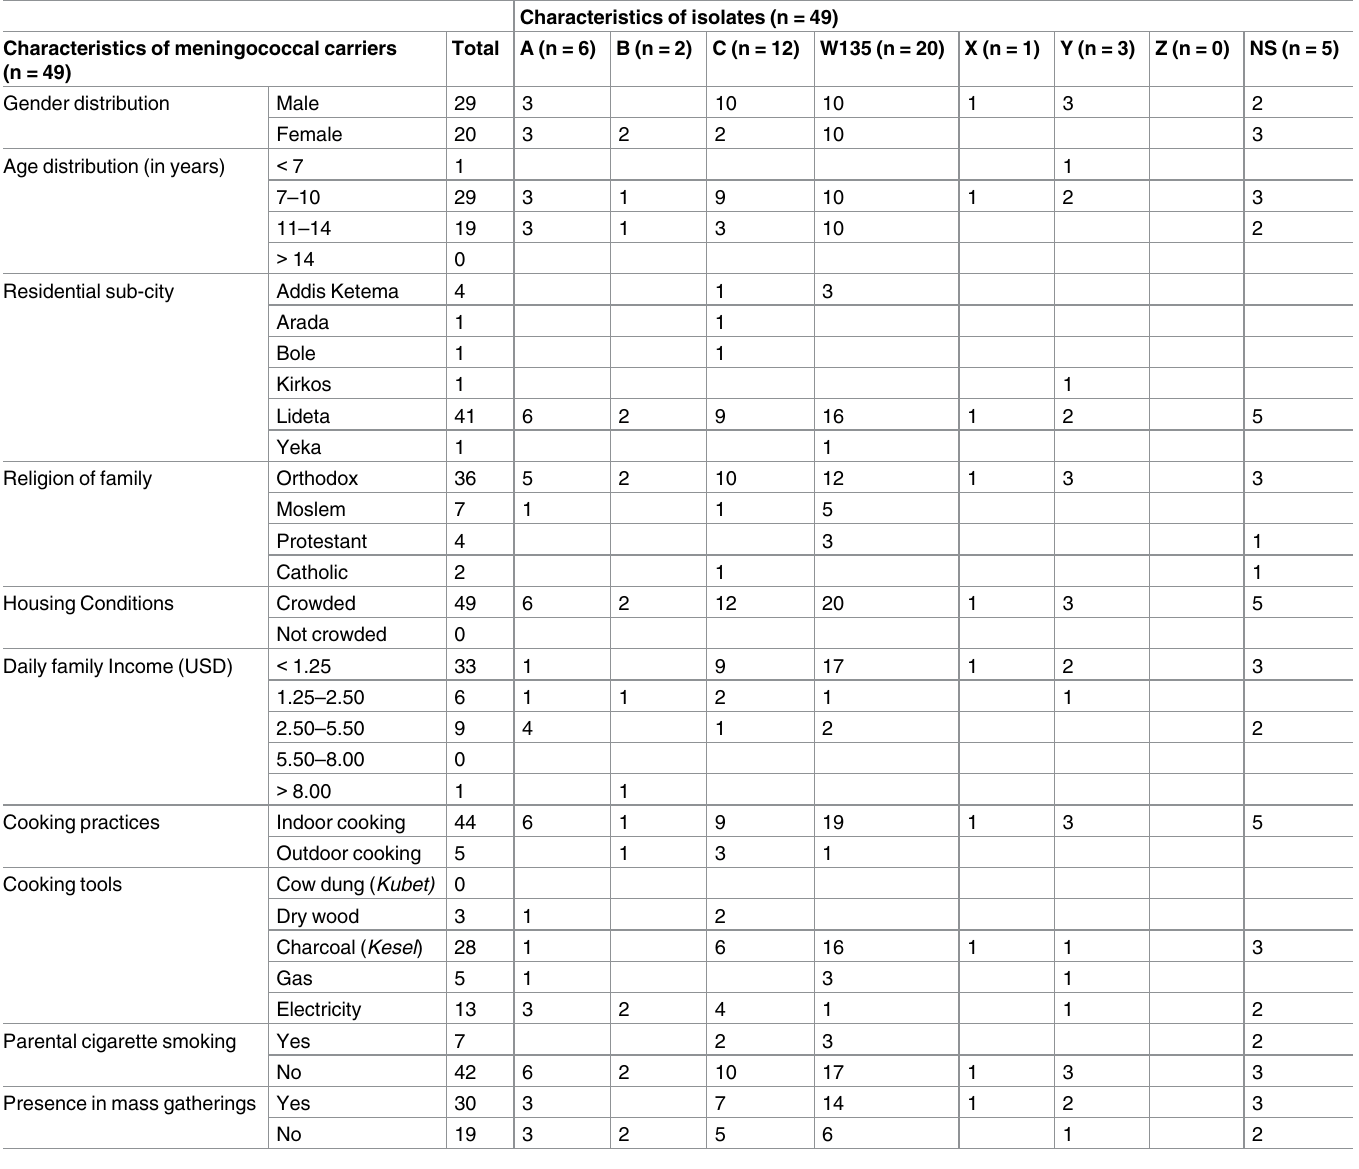
Characteristics of isolates (n = 49)